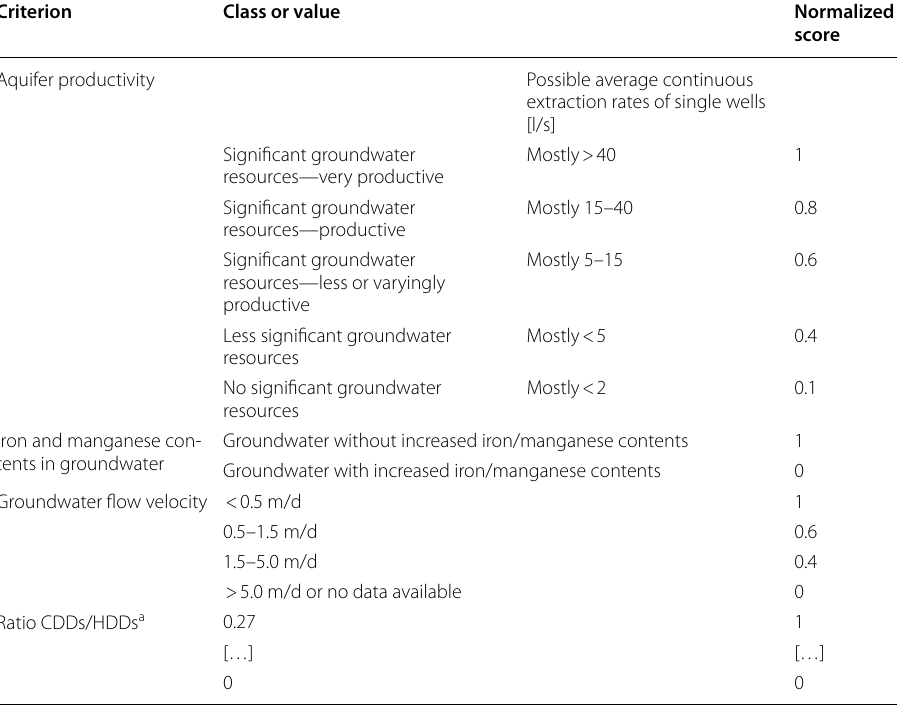
a Calculated according to Eq. (3)